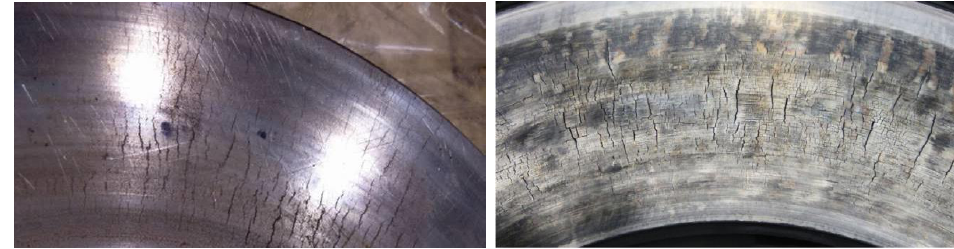
Figure 1. Thermomechanical fatigue of brake disc [6],[7].